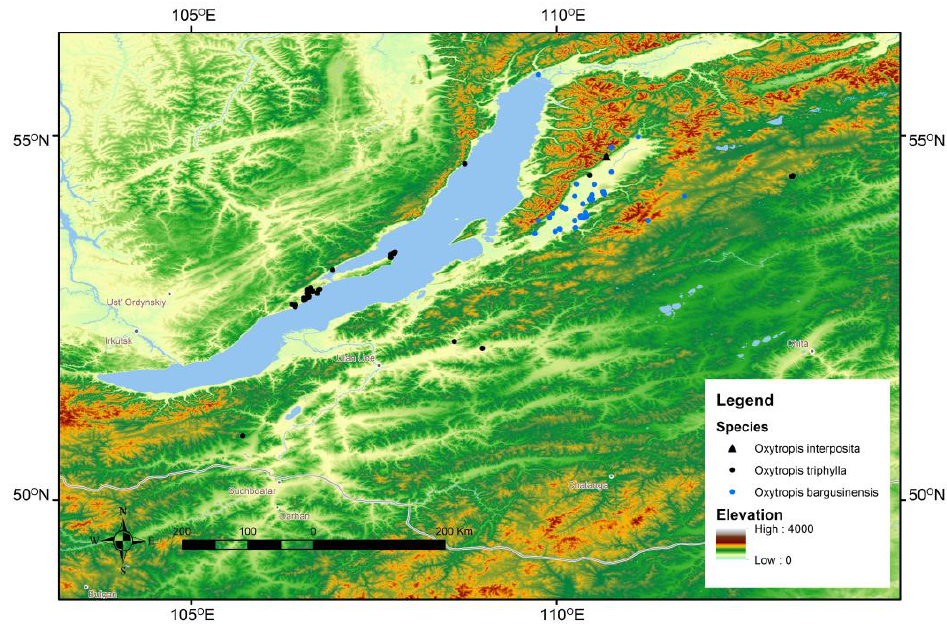
Figure 6. Distribution of three Oxytropis species endemic to Baikal Siberia.